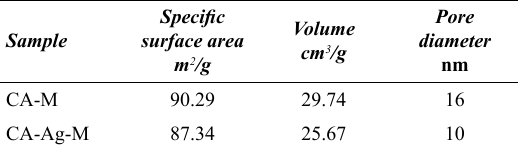
Table 2. Results obtained from the N membranes.